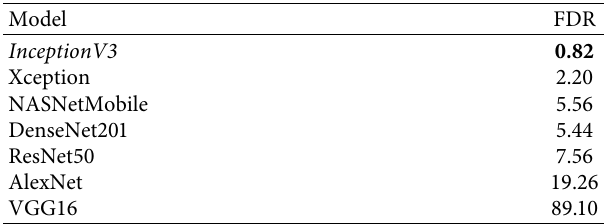
Table 3: False discovery rate (FDR) results for pretrained models. Bold shows it has the lowest FDR.